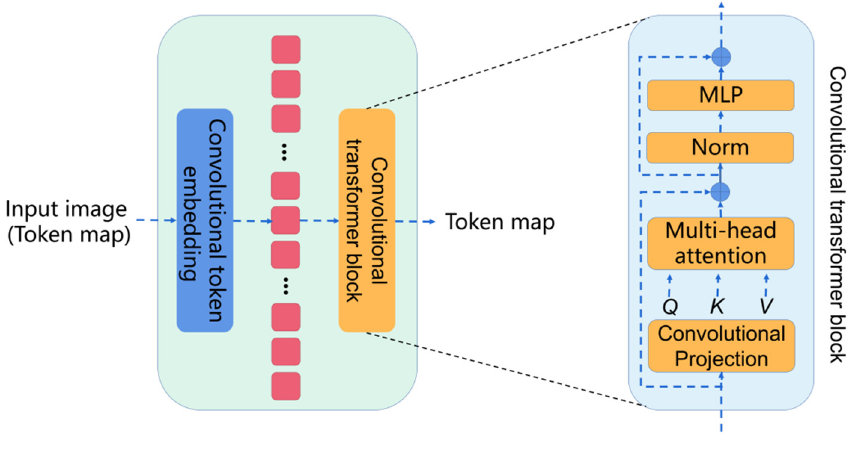
Figure 3. The basic module of the CvT.